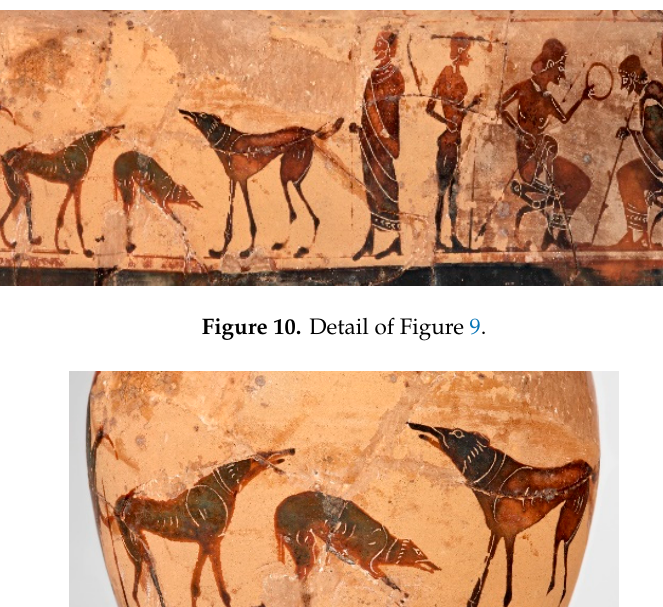
Figure 9. Frieze of dogs (Archäologische Sammlung der Universität Zürich inv. no. 473). Photo: Frank Tomio, image courtesy of the Archäologische Sammlung.